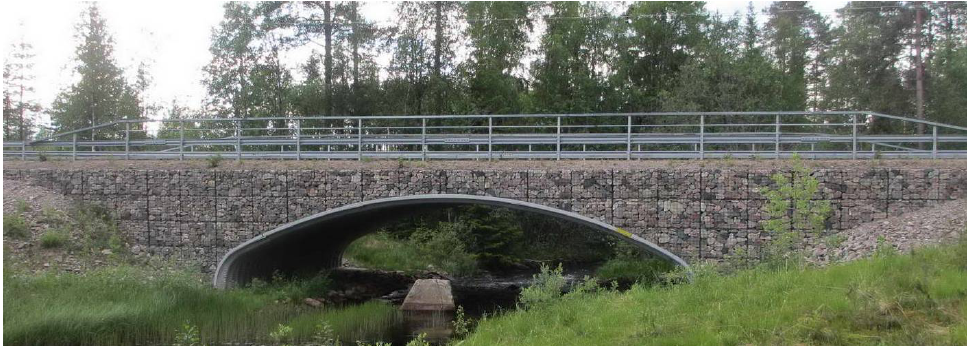
Figure 5. Box culvert bridge over Siktån in Rörbäcksnäs [5].